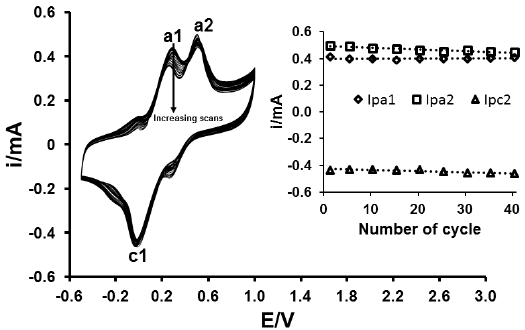
Figure 7. Repetitive cyclic voltammograms (40 scans) recorded at PEDOT:PSS/20%IL/SPCE sensor; insert is peak current vs. cycle number. Voltammograms were recorded in 5.0 mM catechol in PBS (pH 7.4) containing 0.1 M KCl and at a scan rate of 100 mV·s − 1 .